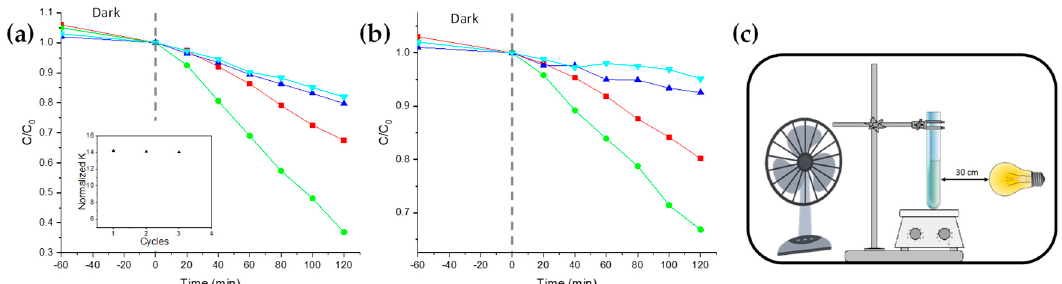
Figure 4. ( a ) Methylene Blue concentration ratio (C/C 0 ) variations in function of the irradiation time in the presence of the thin films of NC1 (green), NC2 (blue), NC3 (cyan), and BL (red). Inset: Rate constant (normalized by weight) during the reuse of the NC1 thin film with MB. ( b ) The same plot is reported for Rhodamine B photodegradation. ( c ) Simplified scheme of the open-wall homemade apparatus employed in these experiments.